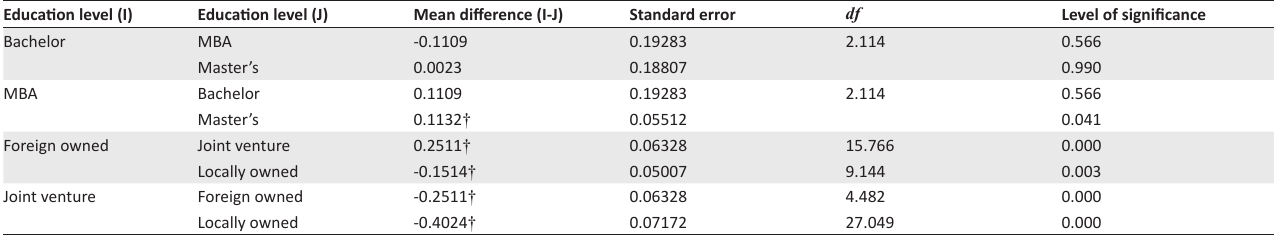
TABLE 4: Post hoc test for organisational change – education and type of enterprises. Education level (I)